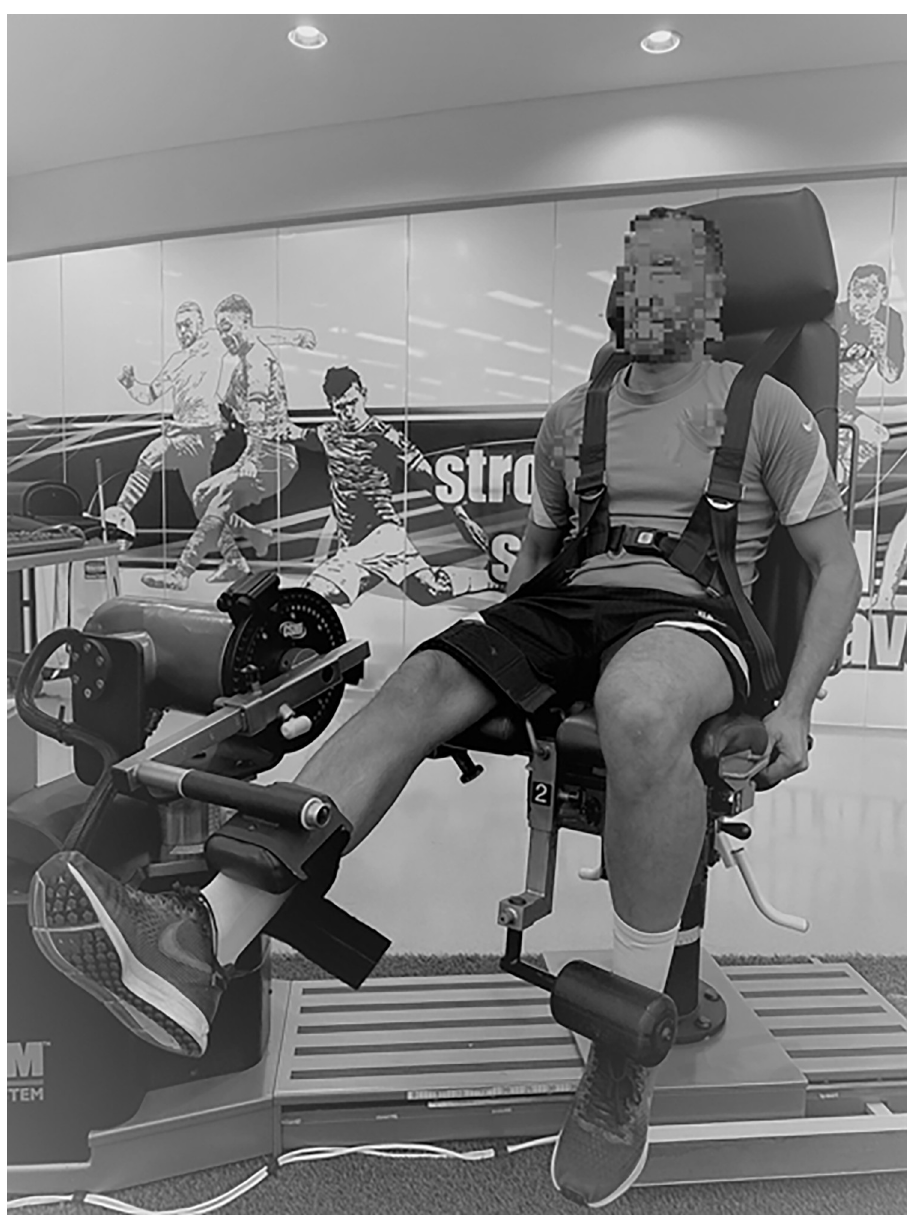
Fig 2. Isokinetic knee flexion and knee extension. (DL) and non-dominant leg (NDL). The peak torque was observed for knee flexor in concen- tric actions at 30˚ � s -1 and 60˚ � s 1 angular velocities, and at 90˚ � s -1 angular velocities for the eccentric actions. Peak torque of knee extension during concentric actions at 60˚ � s -1 angular velocities and eccentric 60˚ � s -1 angular velocities have been analyzed. The range of movement was recorded from 90˚ to 0˚ and from 0˚ to 90˚, with 0 defining full knee extension [27], with the hip flexion angle fixed at 90˚. The best peak torque trials (N � m) for each angular velocity, was recorded and subsequently normalized for the lean muscle mass of the considered lower limb (N � m � Kg –1 ) [28].